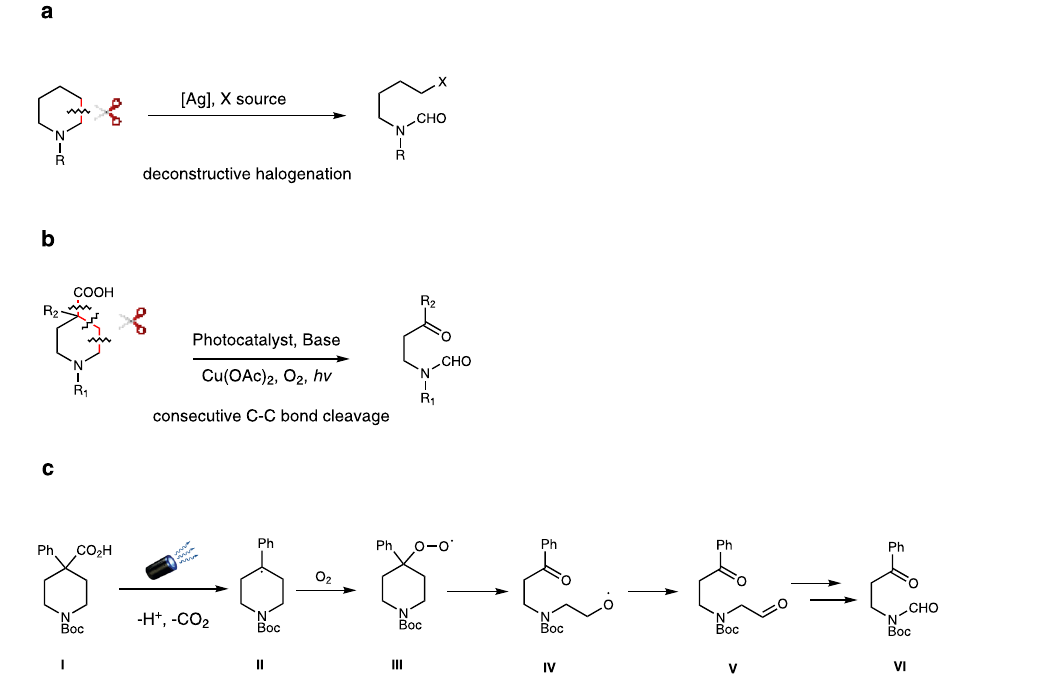
Fig. 1 | C-C bond cleavage of cyclic amines and proposed reaction design. a Previous work by Sarpong. b This work. c Proposed reaction